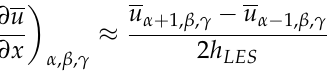
field with the spatial step h LES = ∆ /4. The derivatives of filtered fields on the RHS of